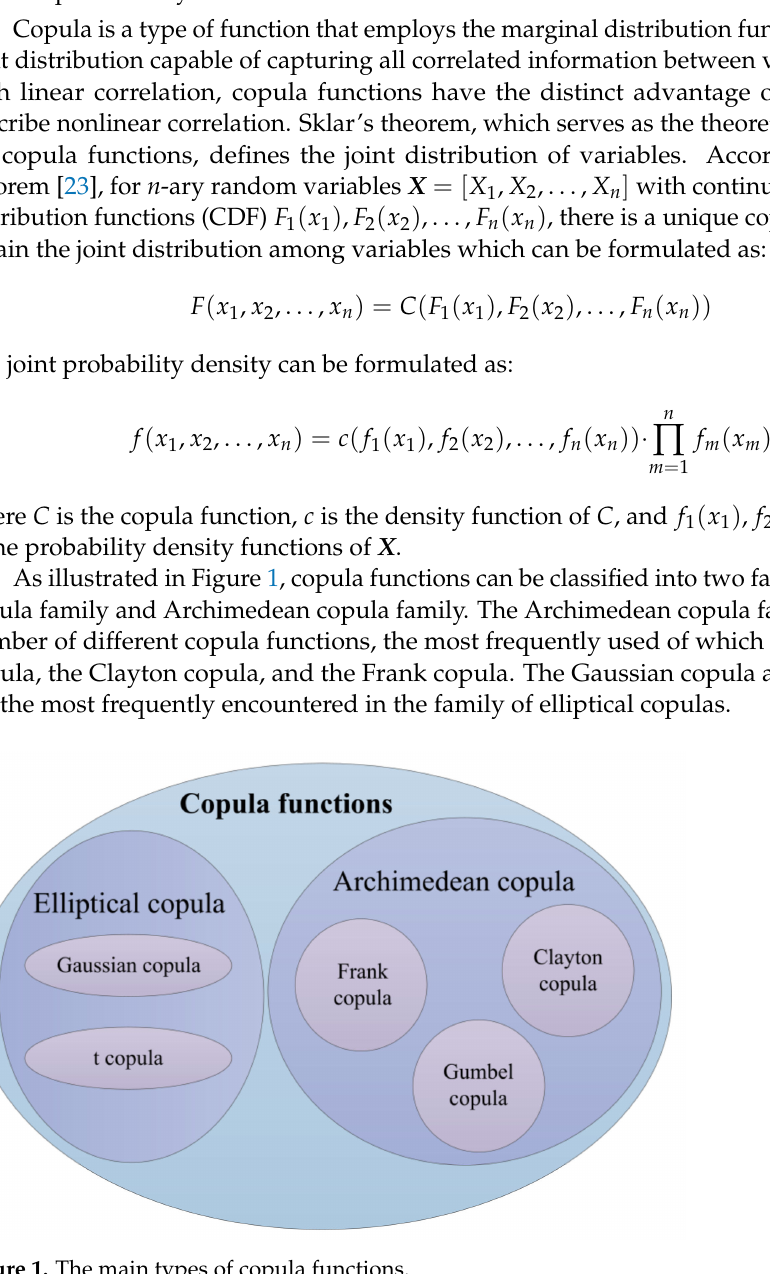
Figure 1. The main types of copula